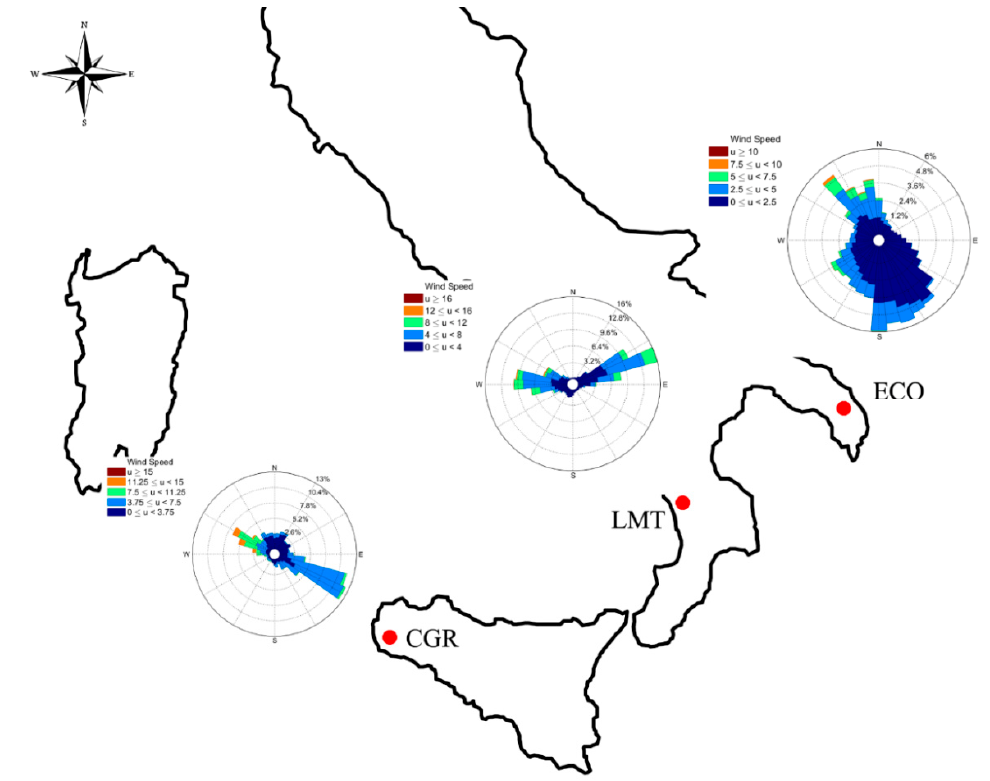
Figure 1. Geographical location of the three GAW regional observatories in Southern Italy (red points). Wind rose for the measurement period at CGR, LMT, and ECO observatories are shown.